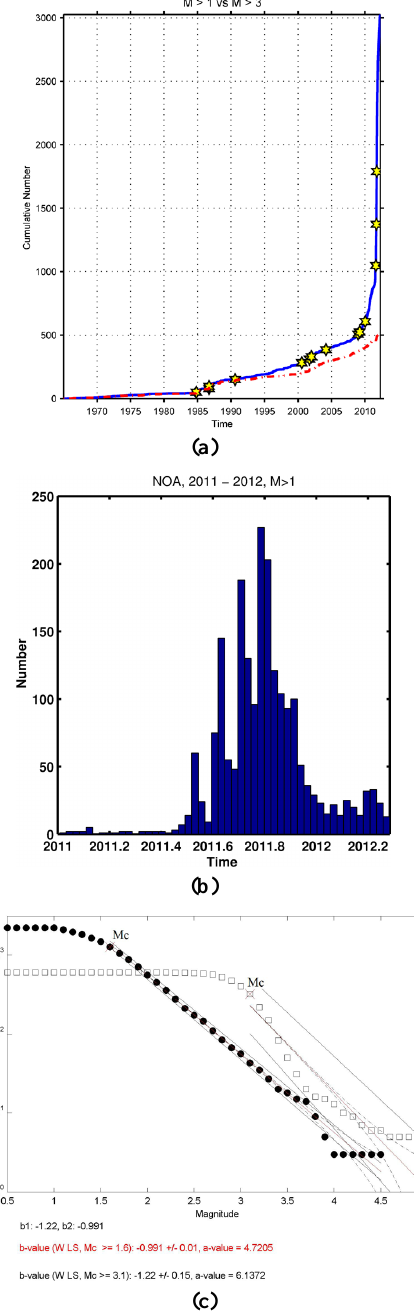
Fig. 3. (a) Cumulative seismicity of the Messinia basin area for the period 1964–2012. The blue curve includes all earthquakes with M > 1 and the red curve all earthquakes with M > 3. Yel- low stars indicate events with M > 4. (b) Time histogram for the 2011 seismic swarm indicating a bell-shaped, Gaussian distribution. (c) Comparison of the FMD for two time periods. Open circles in- dicate the period before the 2011 swarm (1964–2011) and dark cir- cles a one year period after the initiation of the swarm (June 2011– June